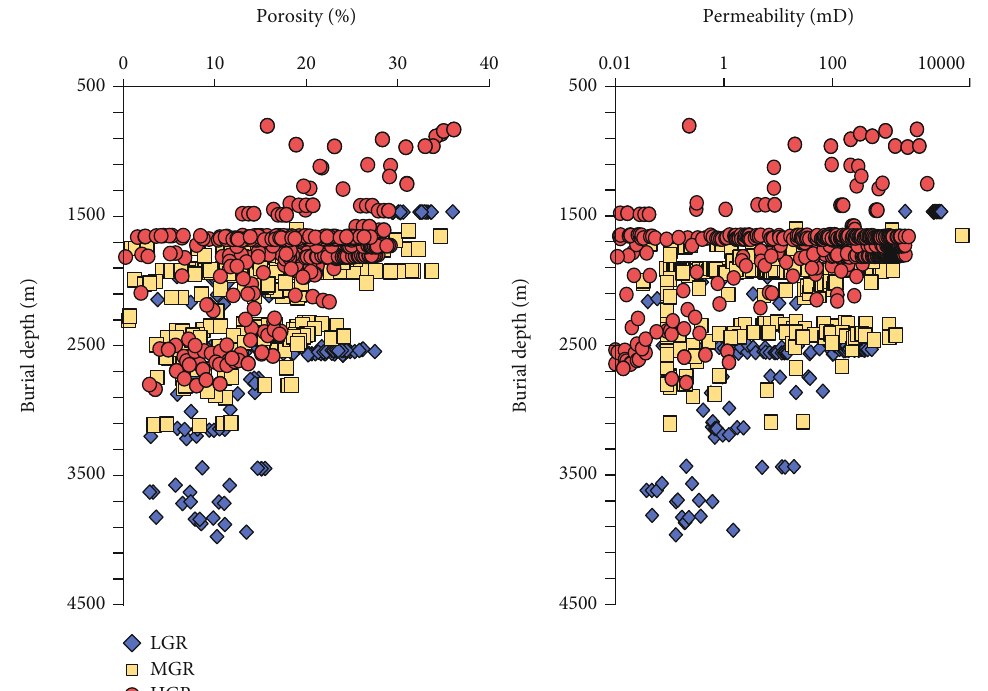
Figure 8: The variation of porosity and permeability versus burial depth of samples in di ff erent geothermal gradient regions (modi fi ed from